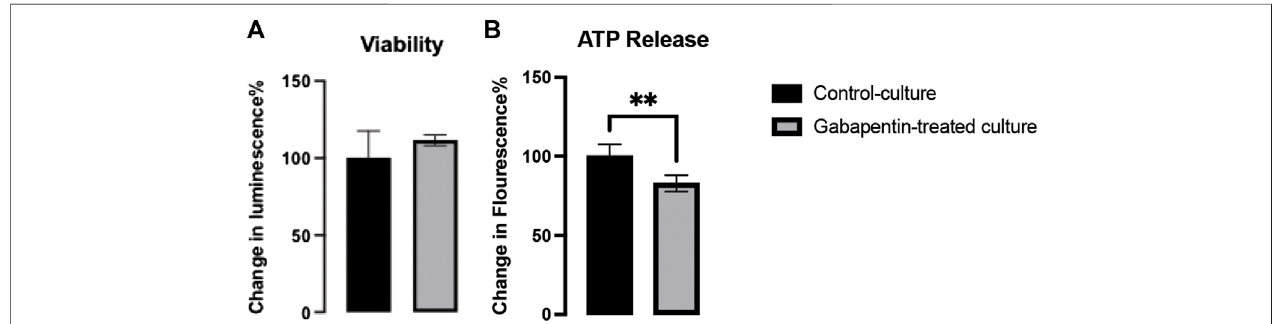
FIGURE 2 | Viability (A) and ATP release (B) in gabapentin-treated and control cultures.